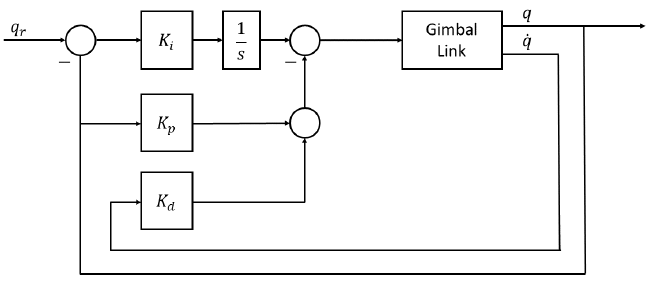
Figure 7. Control architecture for each Link i .